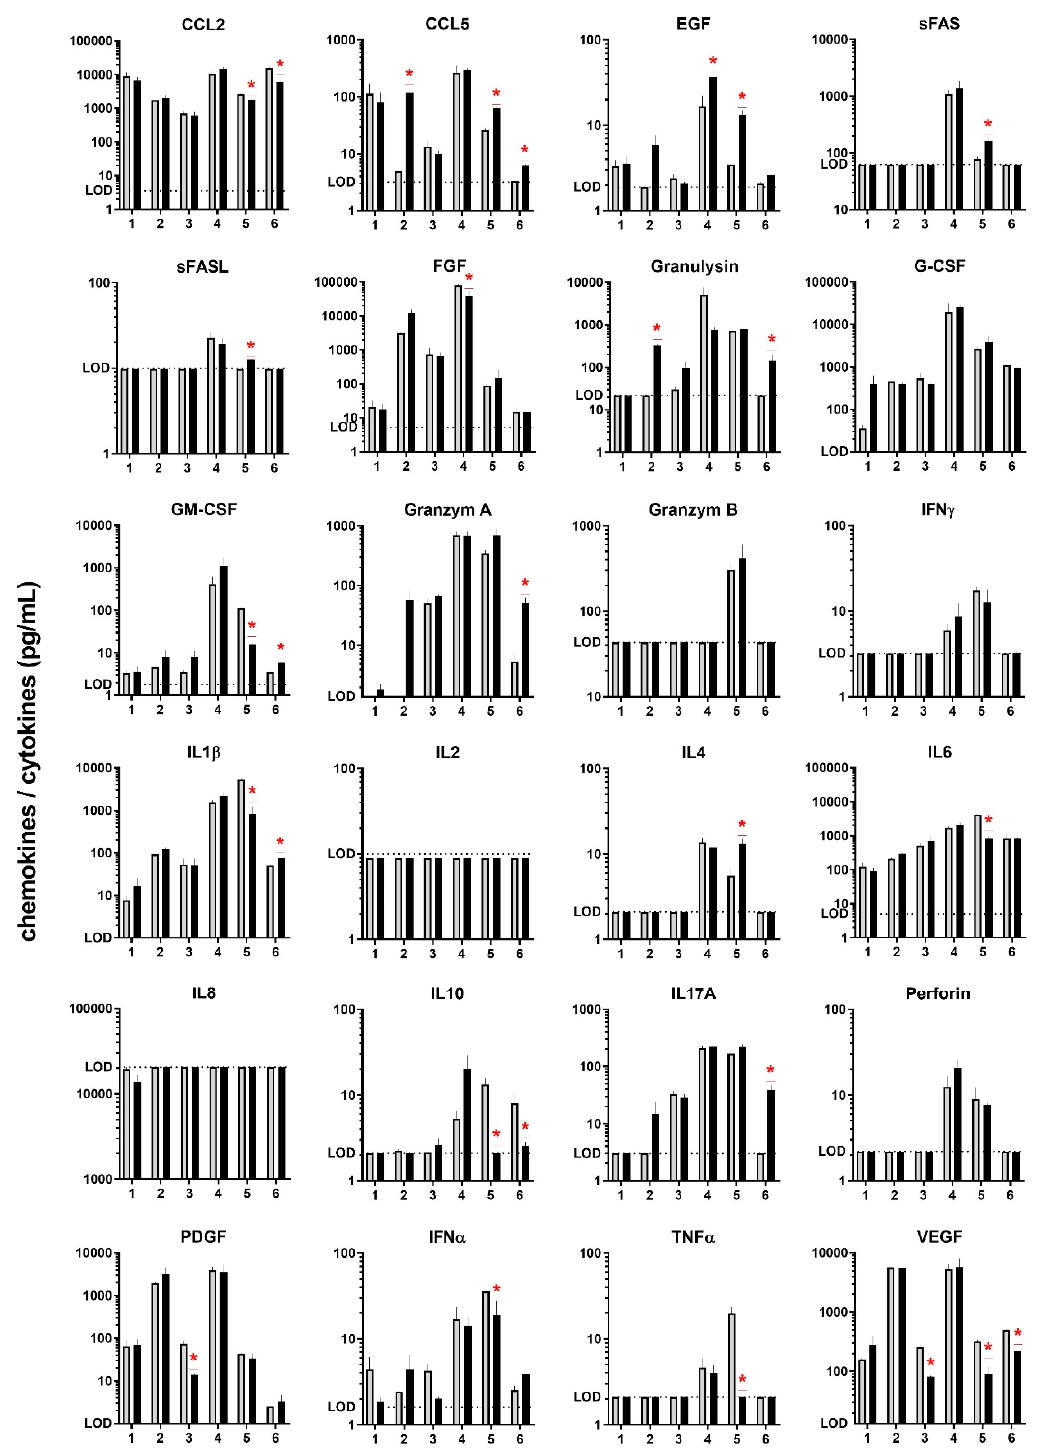
Figure 2. Chemokine / cytokine secretory profile (in pg / mL) of 24 targets measured in culture medium from cutaneous melanoma punch biopsy cultures 24 h after exposure to cold physical plasma (dark bars) or left untreated (grey bars). LOD = lower limit of detection, except for IL8 (upper limit of detection); red asterisks demark significant difference ( p < 0.05) between plasma and control samples for each patient (1–6); given are mean and the standard error of three technical replicates per patient and sample.